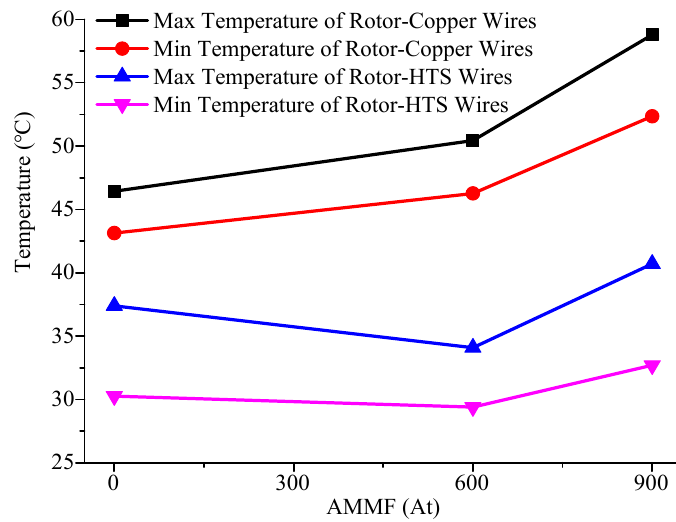
Figure 19. Comparisons of the rotor core temperature of the machine developed by using copper wires and High Temperature Superconducting (HTS) wires.